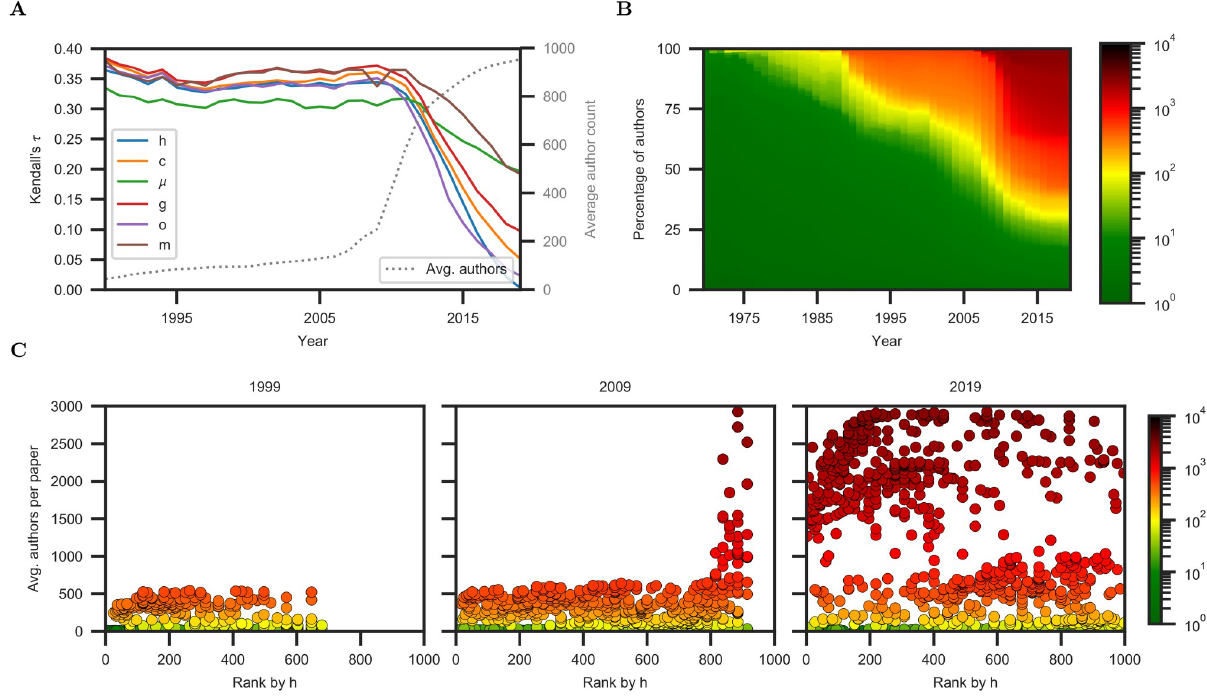
Fig 1. The effectiveness of scientometric measures is declining. ( A ) Effectiveness of scientometric measures as correlates of scientific awards in the Scopus physics dataset. ( B ) Color-coded distribution of the average number of coauthors per publication in this dataset. ( C ) Ranking of physicists by the h-index. Each data point is a scientist. Color and the vertical axis represent the average number of coauthors per publication.